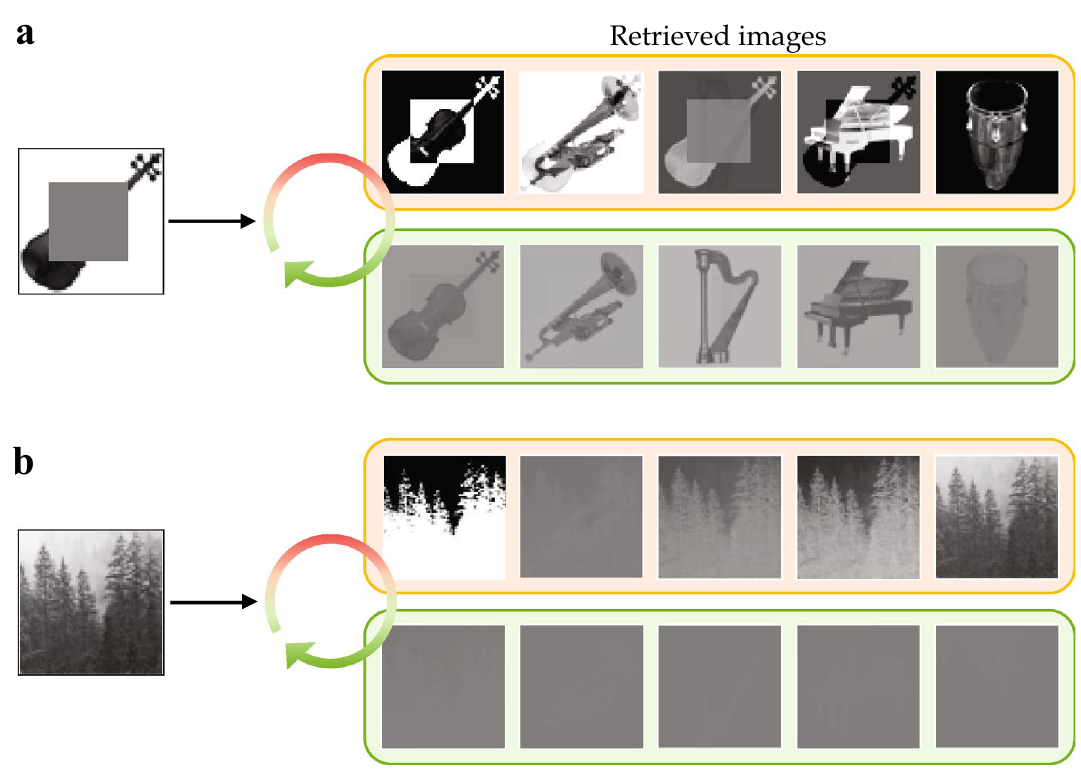
Figure 5. ( a ) Result of retrieval from a partially obstructed cue. Snapshots of the retrieved images are taken at the farthest point from S (top row) and at the intersection of the orbit and the memory plane (bottom row). Here, p ( t † ) ≈ 0.0273 , and p ≈ 0.1092 . ( b ) Result of retrieval from an irrelevant cue. Snapshots of the retrieved images are taken at the farthest point from S (top row) and at the intersection of the orbit and the memory plane (bottom row). Here, p ( t † ) ≈ 0.0000 , and p ≈ 0.0015 . In both ( a ) and ( b ), we used the noisy tag vector Fig. 3 for